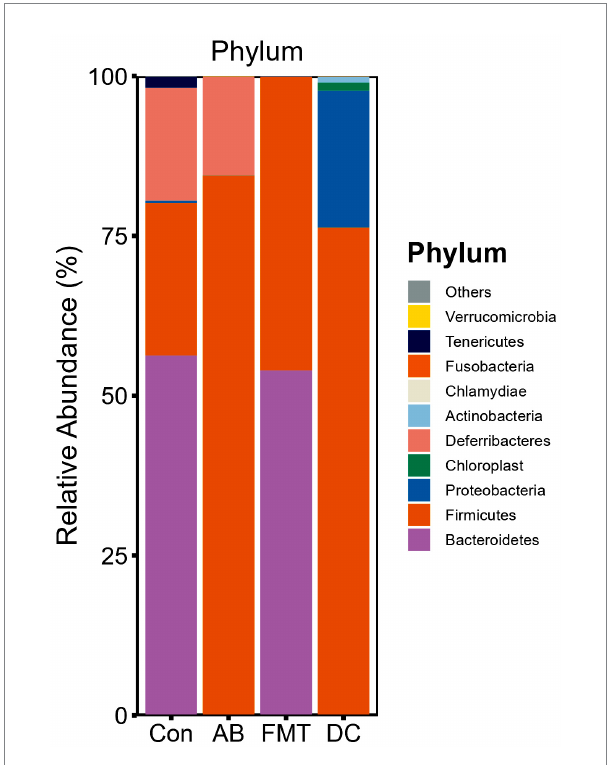
FIGURE 3 Relative abundance ratio of the intestinal microbiome at the phylum level in each experimental group. Data are presented as the percentage of species, and the results were obtained using the Kruskal–Wallis test. Con, Control group; FMT, fecal microbiota transplantation group; AB, antibiotic group; DC, donor